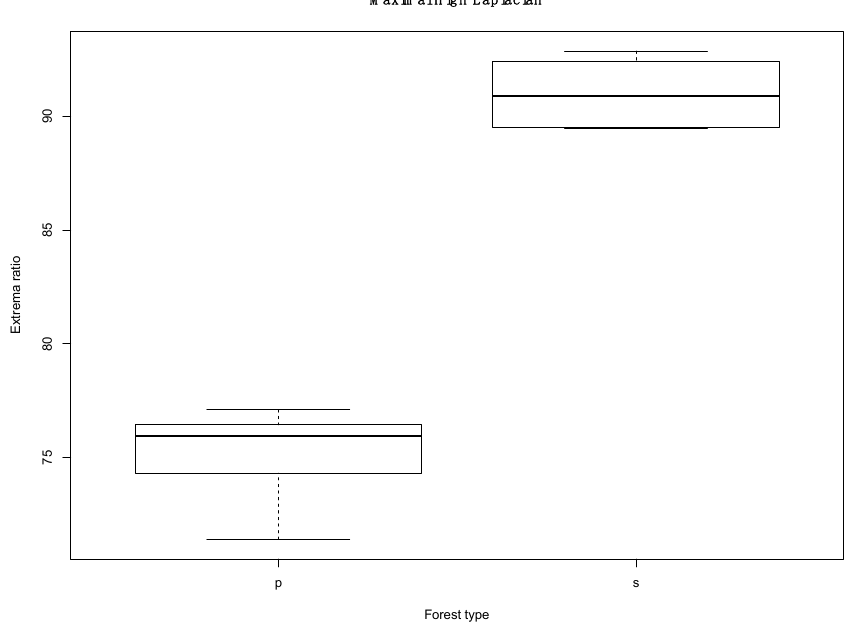
Figure 9. Comparison of relative high Laplacian value for plantations (p) and 91E0 habitats (s). Boxplot graph represents median value (black line), first and third quartile (box), maximum and minimum (whiskers).